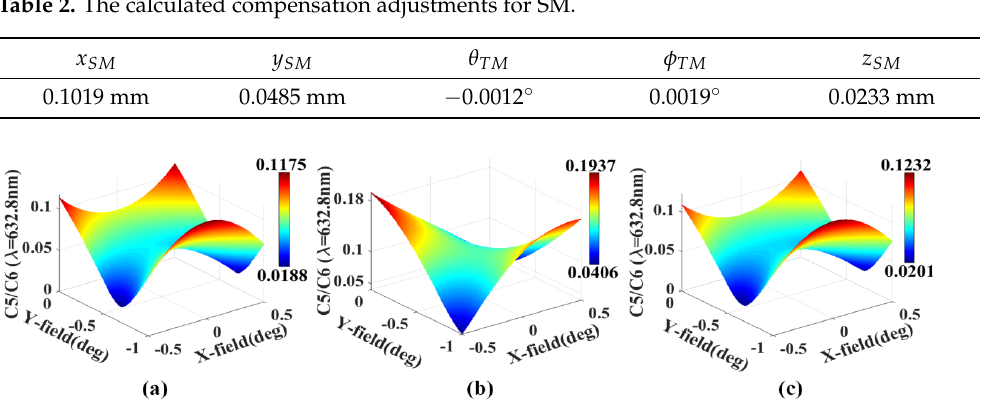
Figure 2. Distribution of Fringe Zernike astigmatism (C5/6) in the full-field of the off-axis TMA telescope: ( a ) before perturbation, ( b ) after perturbation, and ( c ) after compensation correction.